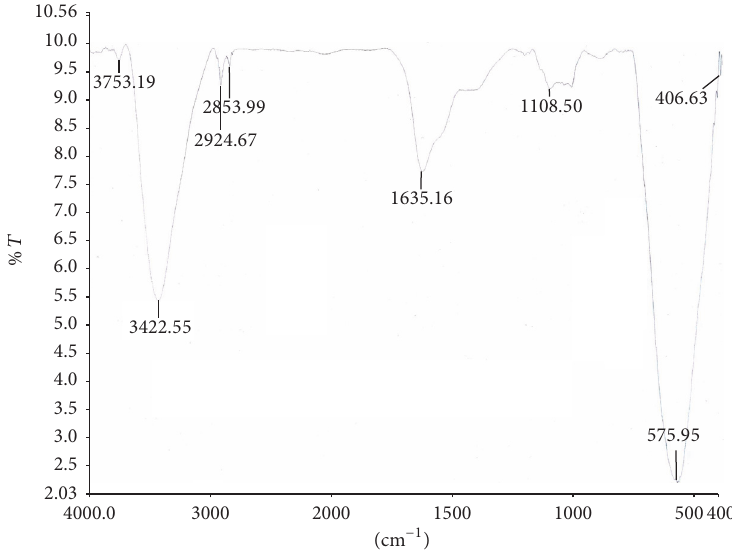
Figure 2: Infrared spectrum of prepared CuO NPs.